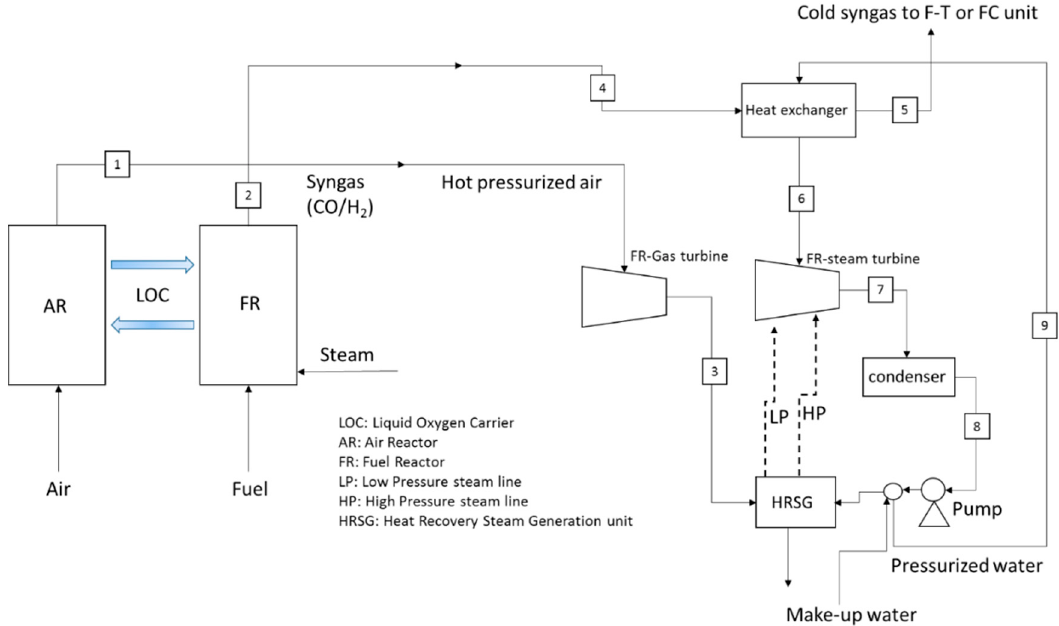
Figure 2. Configuration of the proposed power block to be integrated into an LCLG system (gas turbine combined cycle—GTCC), which can operate with molten copper oxide only.